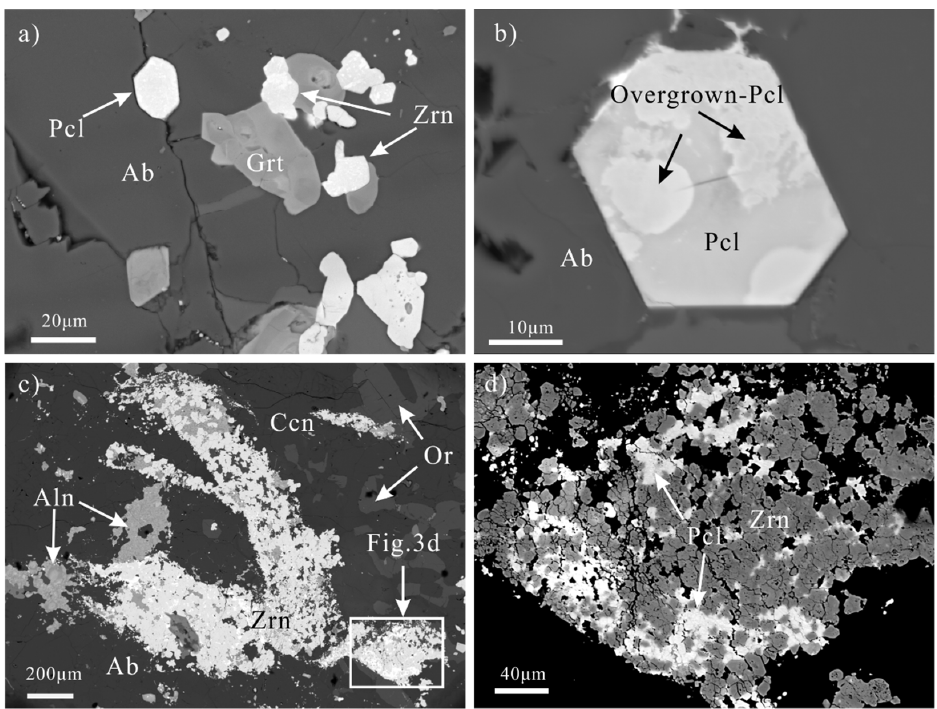
Figure 3. Backscattered electron (BSE) image of Nb-bearing mineral assemblage in a nepheline syenite. ( a ) Type-1 pyrochlore (Pcl) and zircon (Zrn) association with garnet (Grt). ( b ) Type-1 pyrochlore crystal overgrown by a Ca-Na-rich pyrochlore. ( c ) Aggregate allanite (Aln) and type-2 zircons distributed in cancrinite and alkaline feldspar. ( d ) Type-2 pyrochlores rich in aggregate zircon.